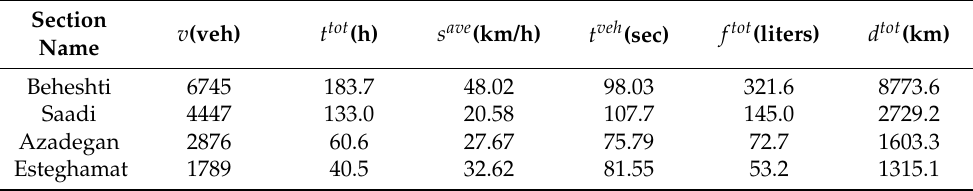
Table 8. AIMSUN performance indicators for the selected roadway sections.